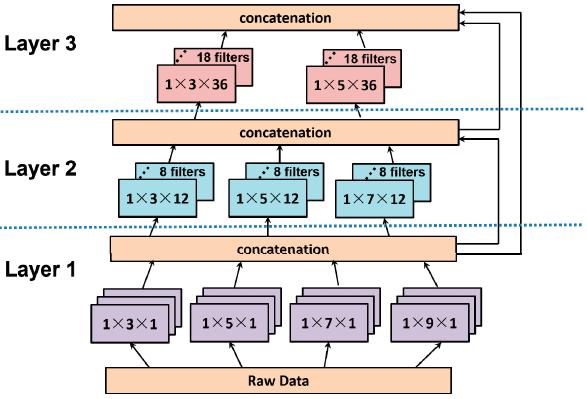
Figure 5. The convolution model in the designed neural network.